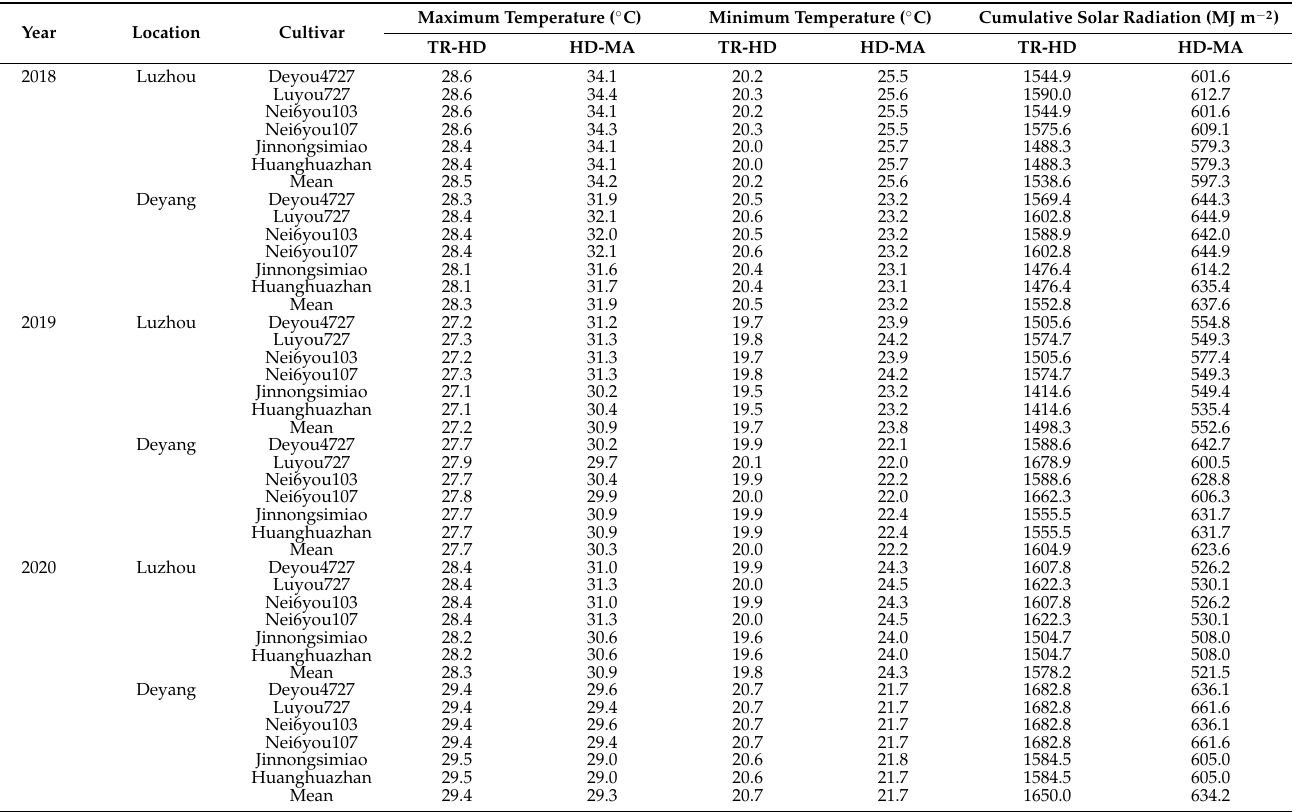
Table 4. Climatic conditions during the growing season of six rice cultivars grown in Deyang and Luzhou, Sichuan Province, China, from 2018 to